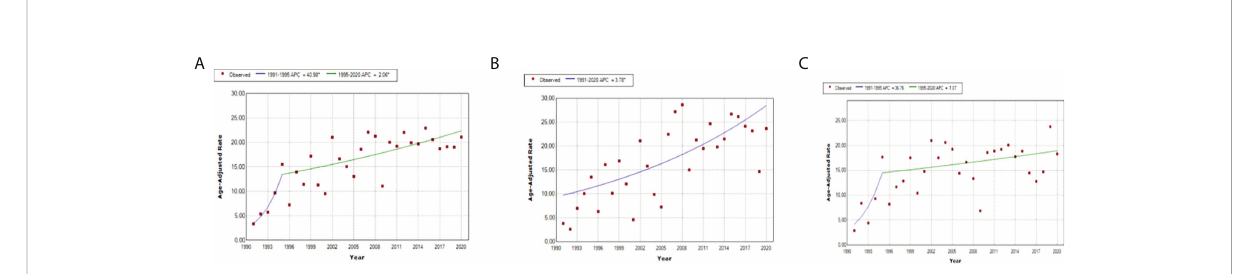
FIGURE 3 Jointpoint regression analysis: trend of standardized incidence rates of T1D in different gender groups, in (A) total, (B) boys, and (C)